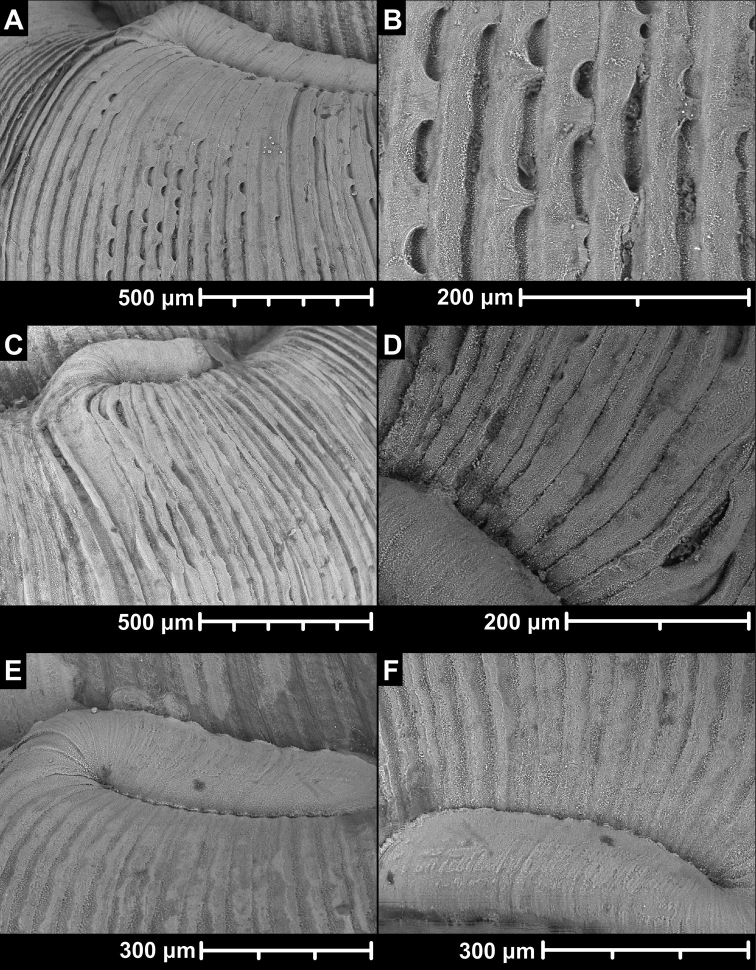
R2 ribs of Japanese Dicharax Kobelt & Möllendorff, 1900 species A, BDicharax
(?)
abei (Kuroda, 1951), NSMT 50125 C, DDicharax (?) biexcisus (Pilsbry, 1902), NSMT 263 E, FDicharax
(?)
itonis (Kuroda, 1943), NSMT 78866. All images: Barna Páll-Gergely.